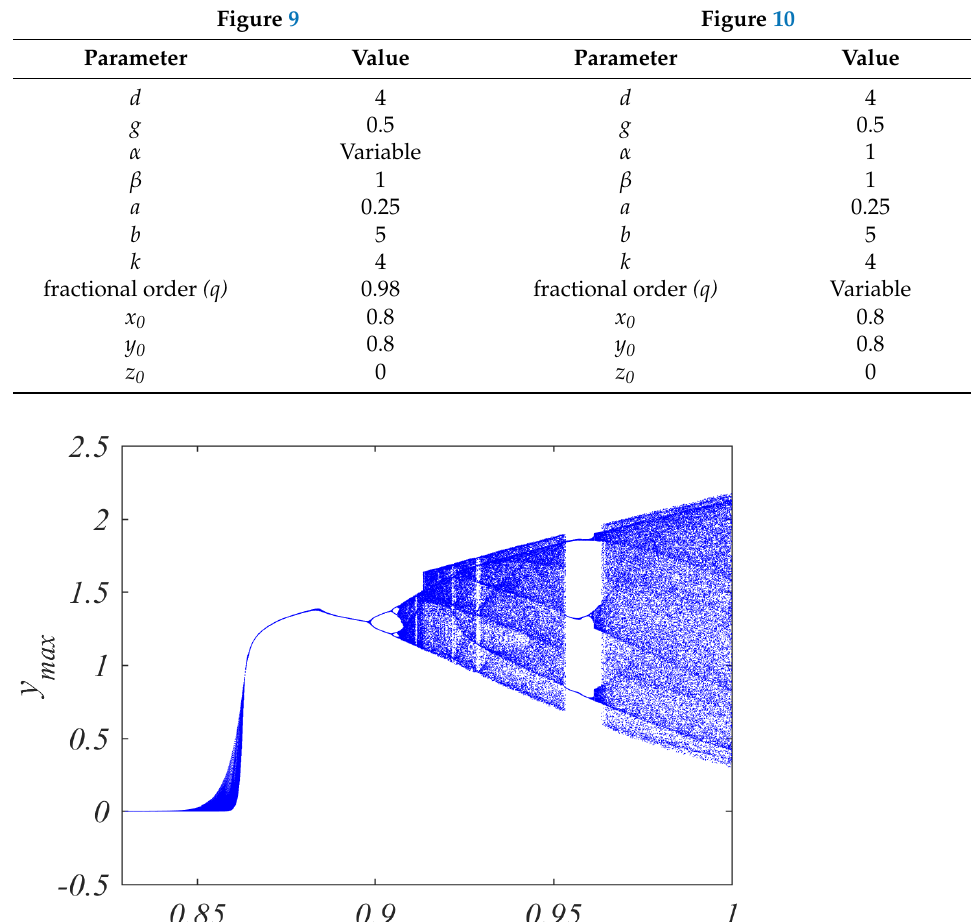
Figure 9. The system (14) bifurcation diagram with respect to changing parameter α . Table 1. The system (14) parameters used in plots of Figures 9 and 10.